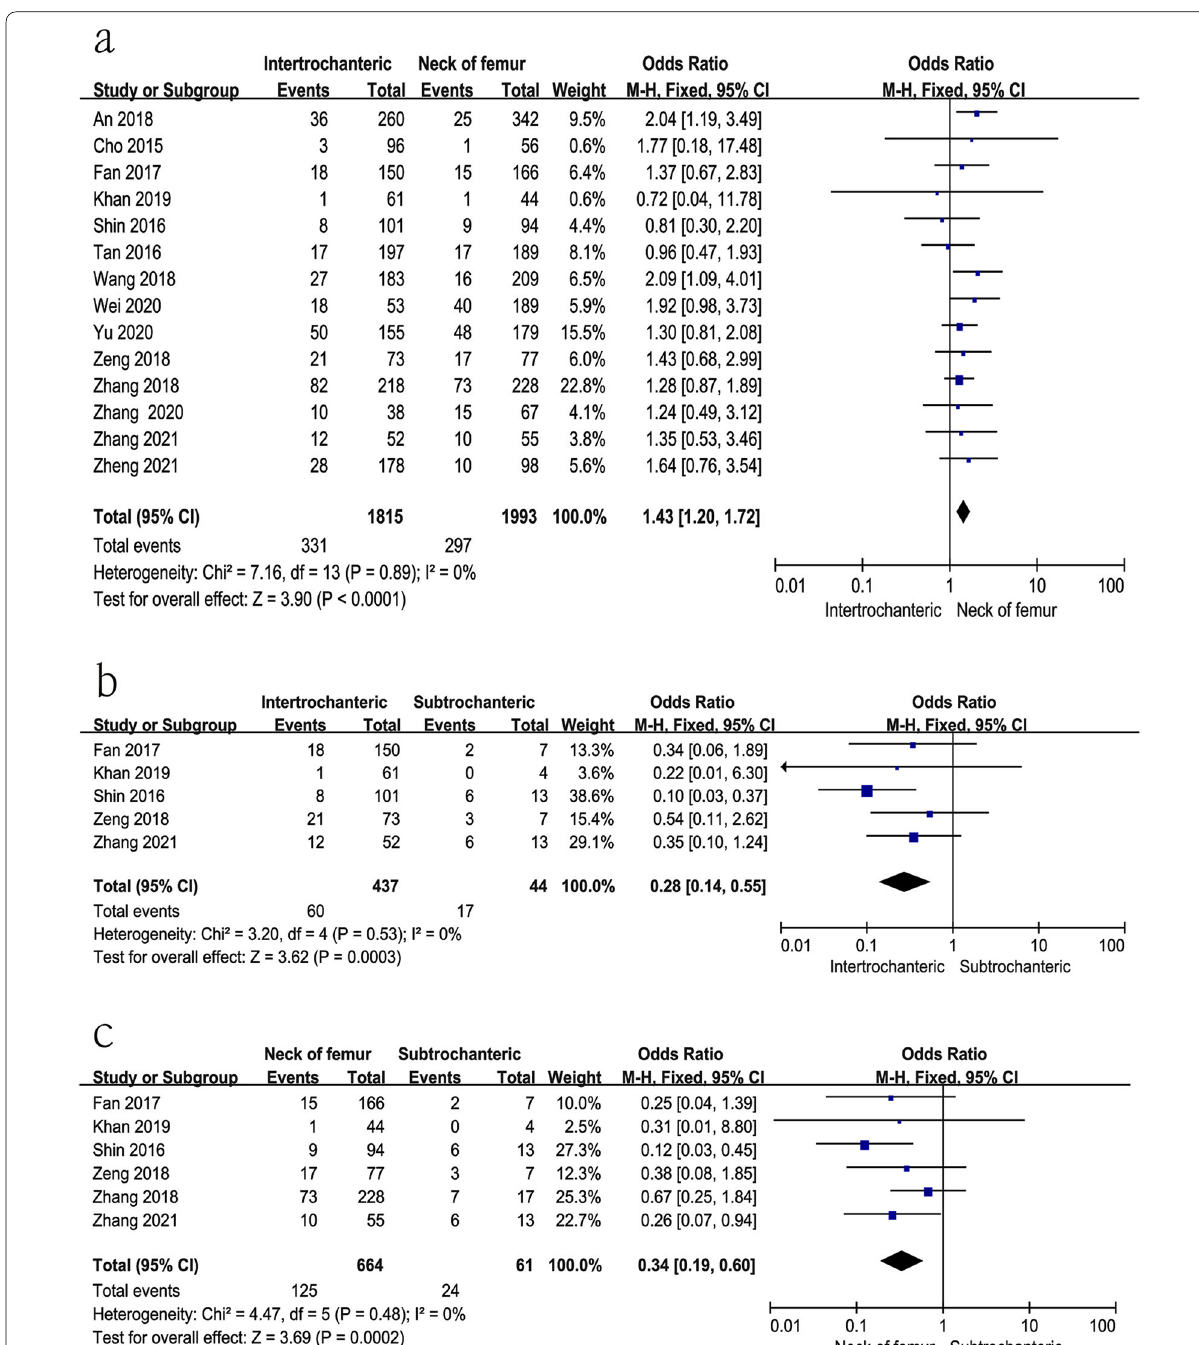
Fig. 5 Forest plot showing type of fracture in 2 groups. CI confidence interval, df degrees of freedom, M-H Mantel–Haenszel. a Intertrochanteric fracture vs femur neck fracture; b intertrochanteric fracture vs subtrochanteric fracture; c femur neck fracture vs subtrochanteric